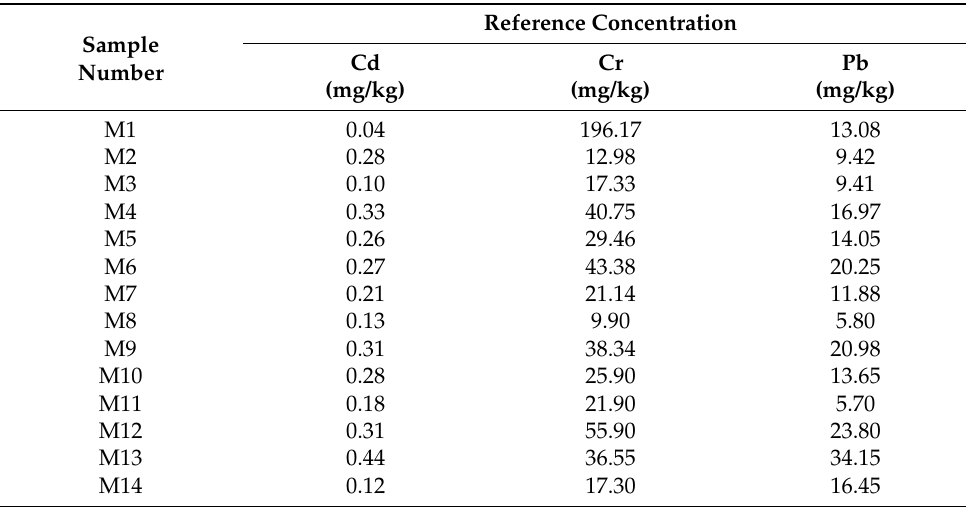
Table 1. The concentrations of heavy metals (Cd, Cr, and Pb) in sediment samples obtained with the ICP-OES